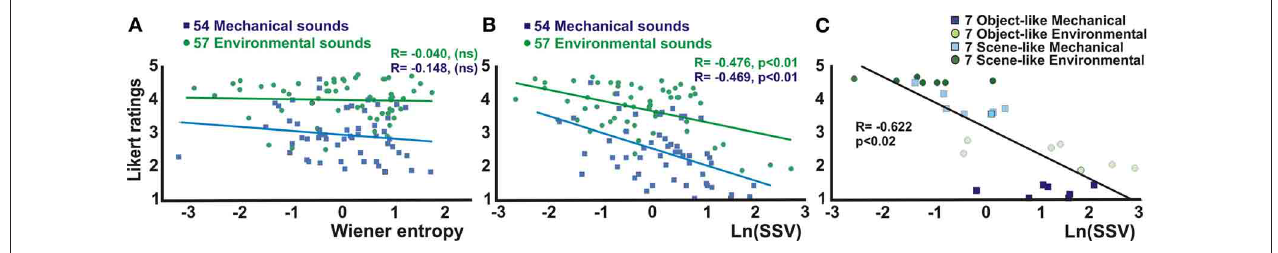
FIGURE 3 | Correlations between acoustic signal attributes and perceptual ratings of object-vs-scene non-biological action sounds. (A) Mean entropy measures ( z -normalized) showed no significant linear correlations between the sound stimuli as a function of the Likert ratings. (B) Spectral structure variation (SSV) measures